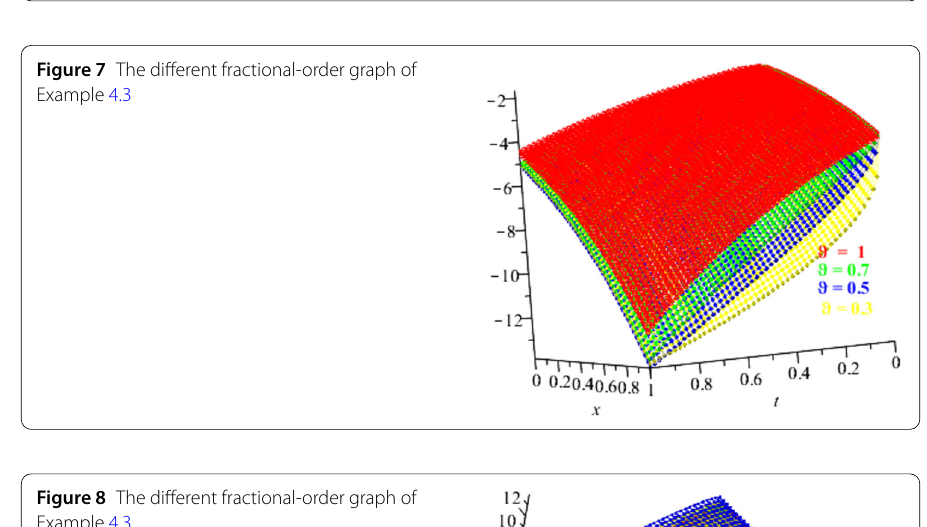
Figure 8 The different fractional-order graph of Example